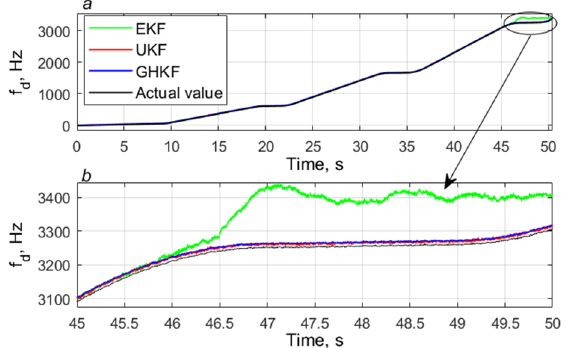
ˆ f . Figure 7. Estimates of Doppler frequency ˆ f d d